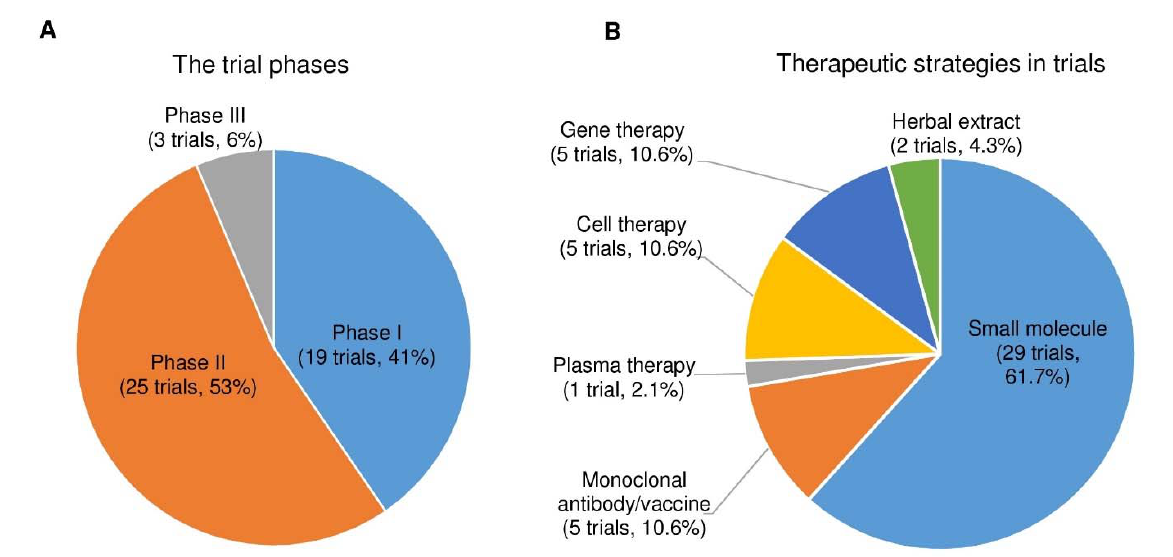
Figure 4. The trial phases and therapeutic strategies in the clinical trials for PD treatment. ( A ) A pie chart shows the individual percentage of phase I, phase II, and phase III trials to the total. The phase I/II or II/III trials on ClinicalTrials.gov are showed as phase I or II, respectively. ( B ) A pie chart shows the proportions of each therapeutic strategy to the total PD clinical trials.